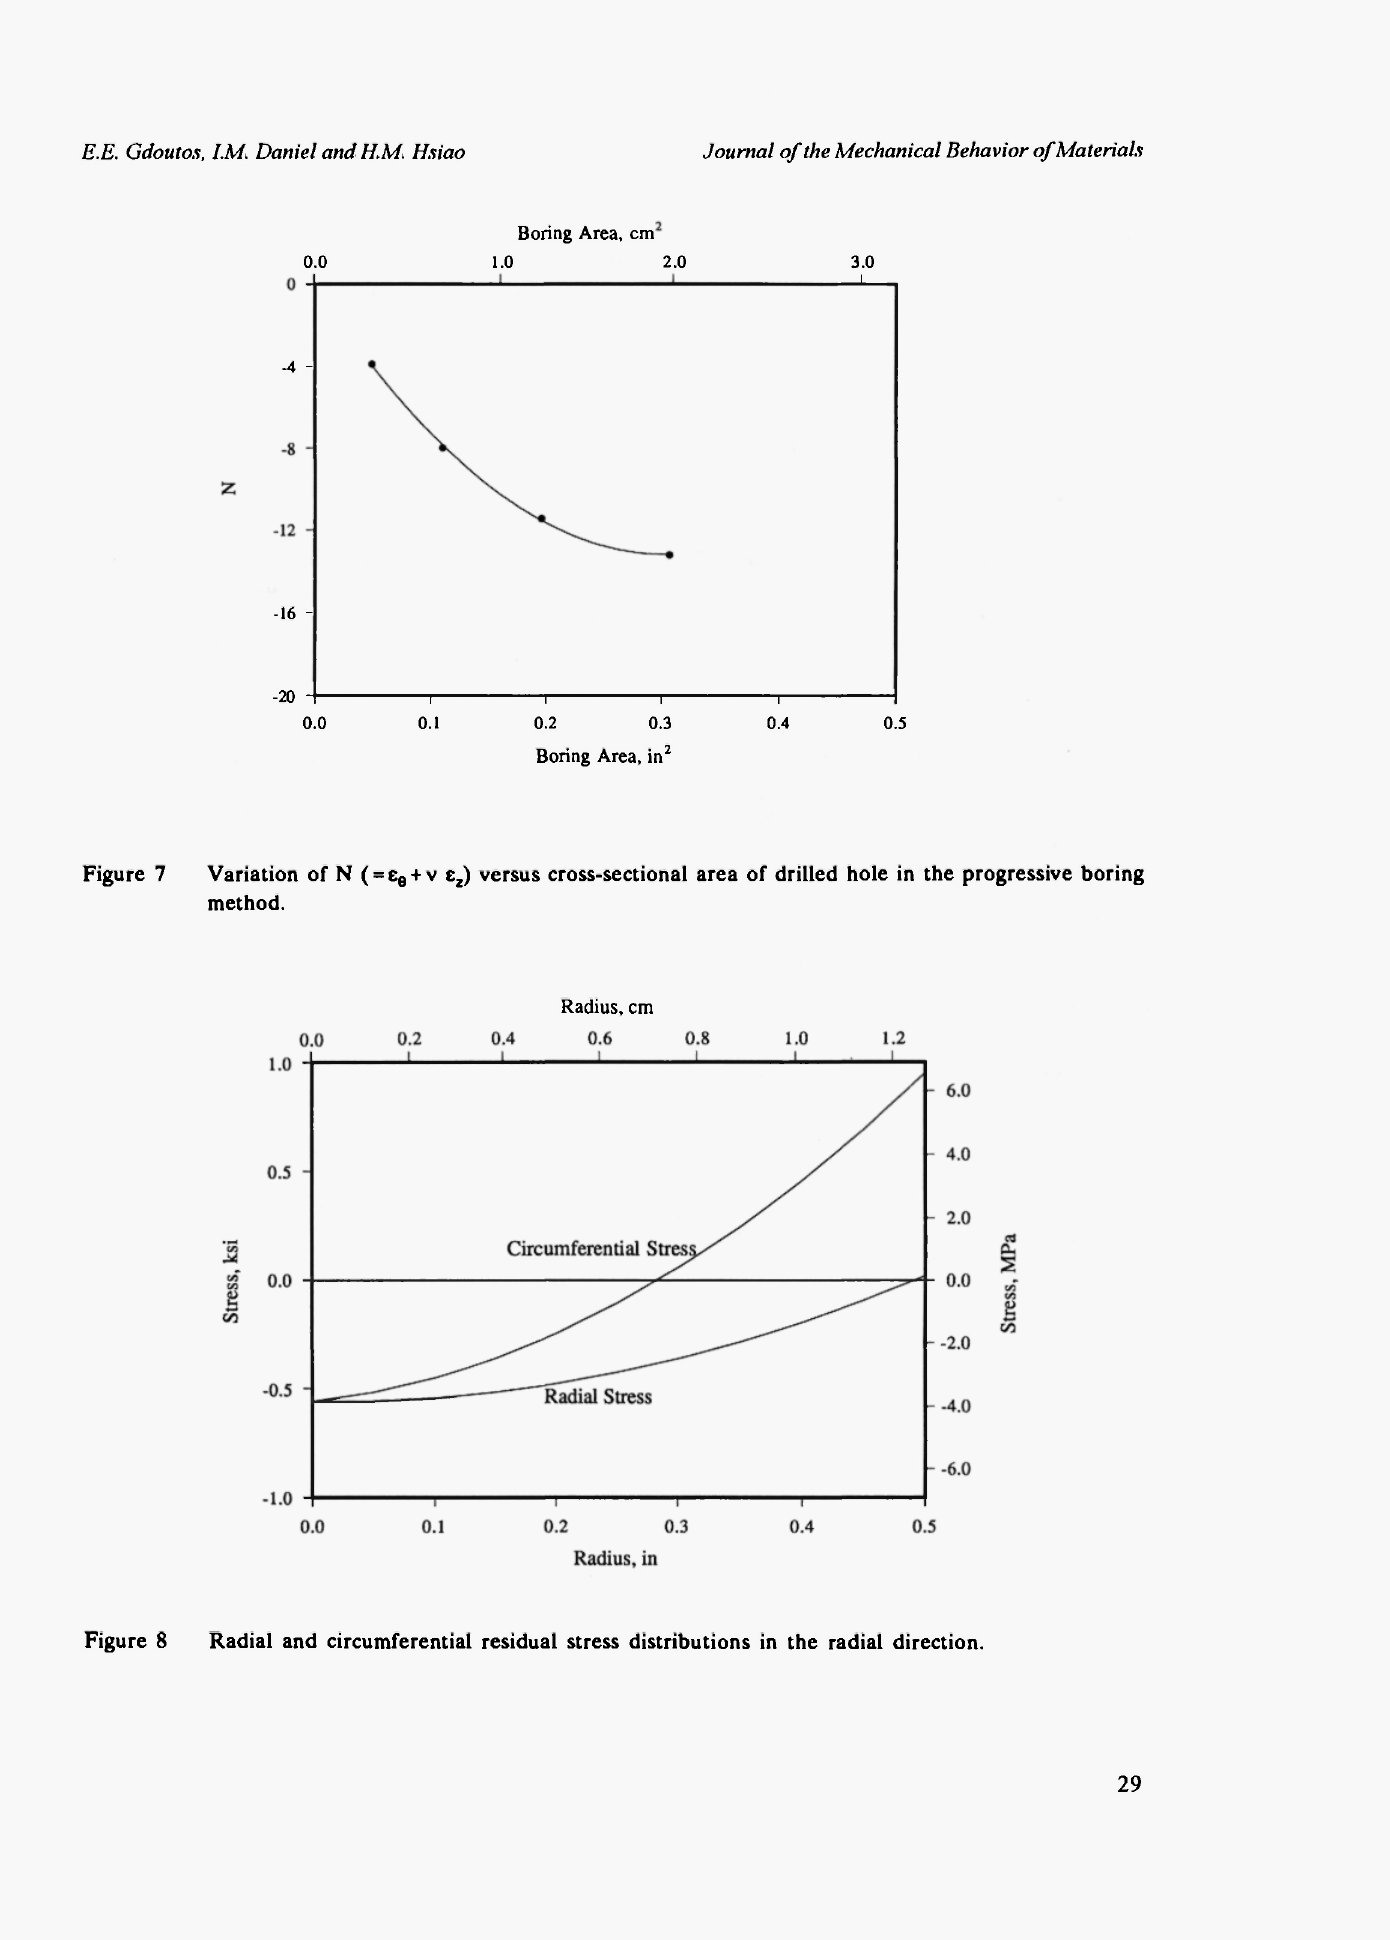
Figure 8 Radial and circumferential residual stress distributions in the radial